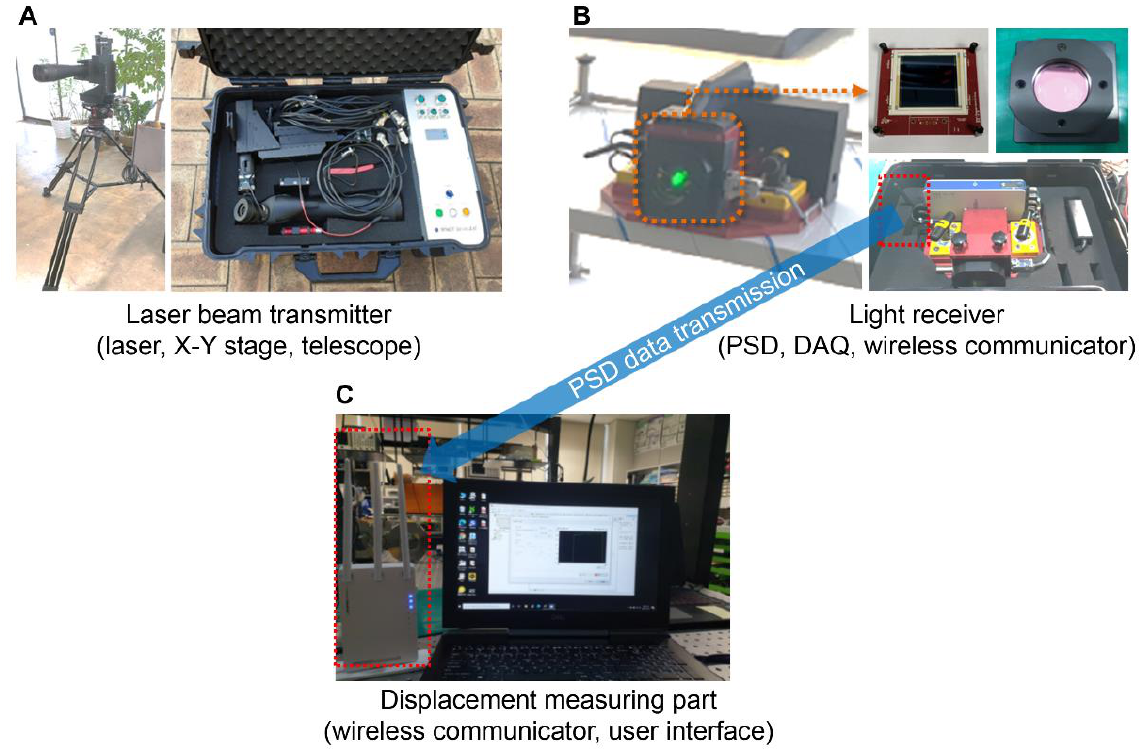
Figure 1. System configuration of the remote displacement sensor. ( A ) Laser beam transmitter including laser, X-Y stage and telescope, ( B ) Light receiver including PSD, DAQ and wireless communicator, ( C ) Displacement measuring part including wireless communicator and user interface)